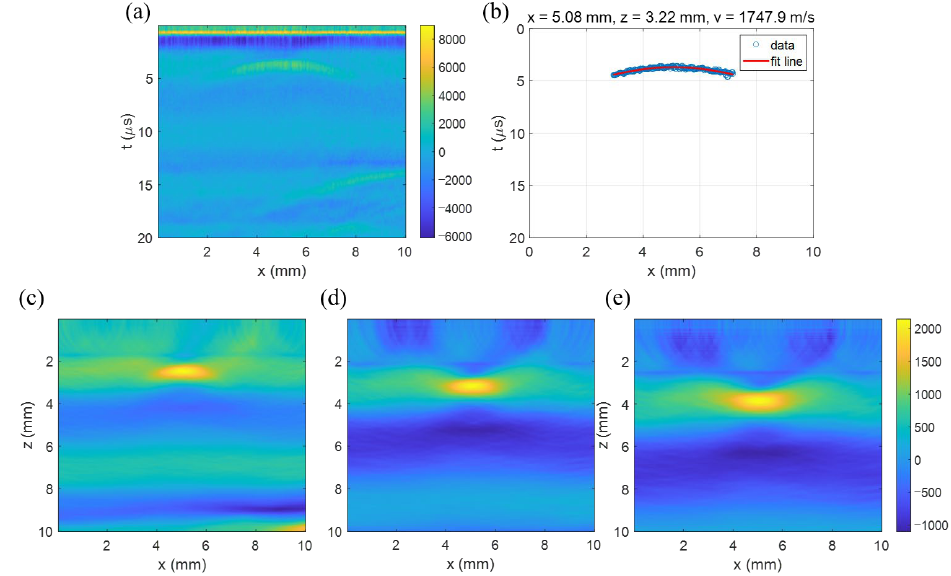
Figure 10. T-SAFT image reconstruction of the chicken breast sample. ( a ) The experimentally acquired B-scan image. ( b ) The hyperbola curve fitting result, which gave the acoustic velocity as 1747.9 m/s. The image reconstruction made with a ( c ) lower velocity of 1398.3 m/s, ( d ) proper velocity of 1747.9 m/s, and ( e ) higher one of 2097.4 m/s. The images are distorted with wrong velocities.